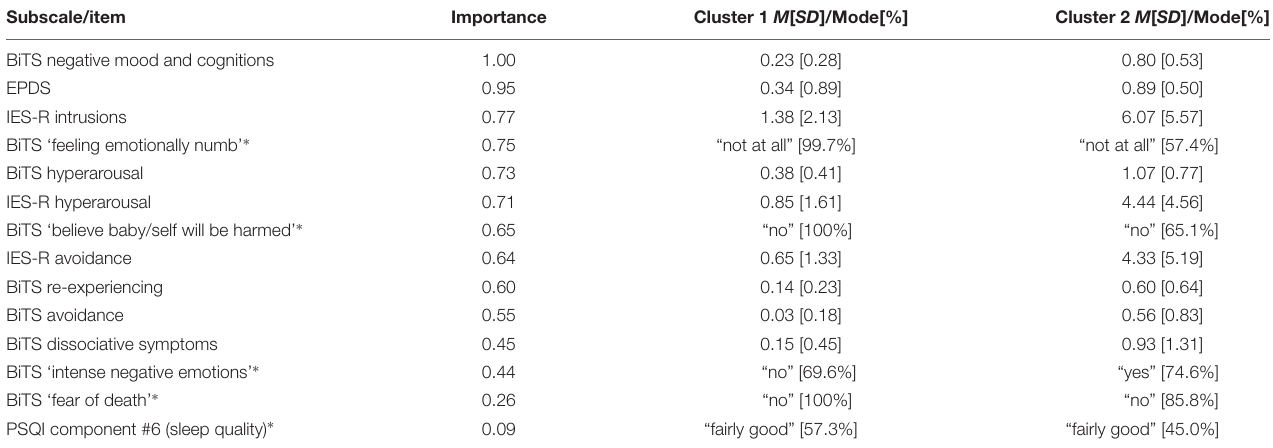
TABLE 5 | Two-step cluster